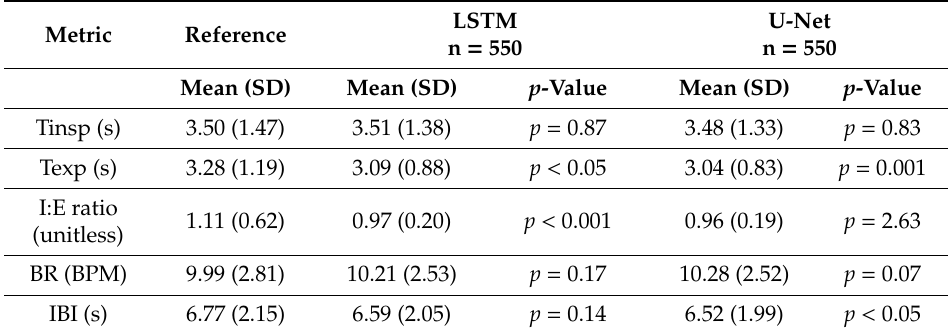
The Pearson correlation and mean bias and 95% limits of agreement (LoA) between derived and gold standard metrics are shown in Table